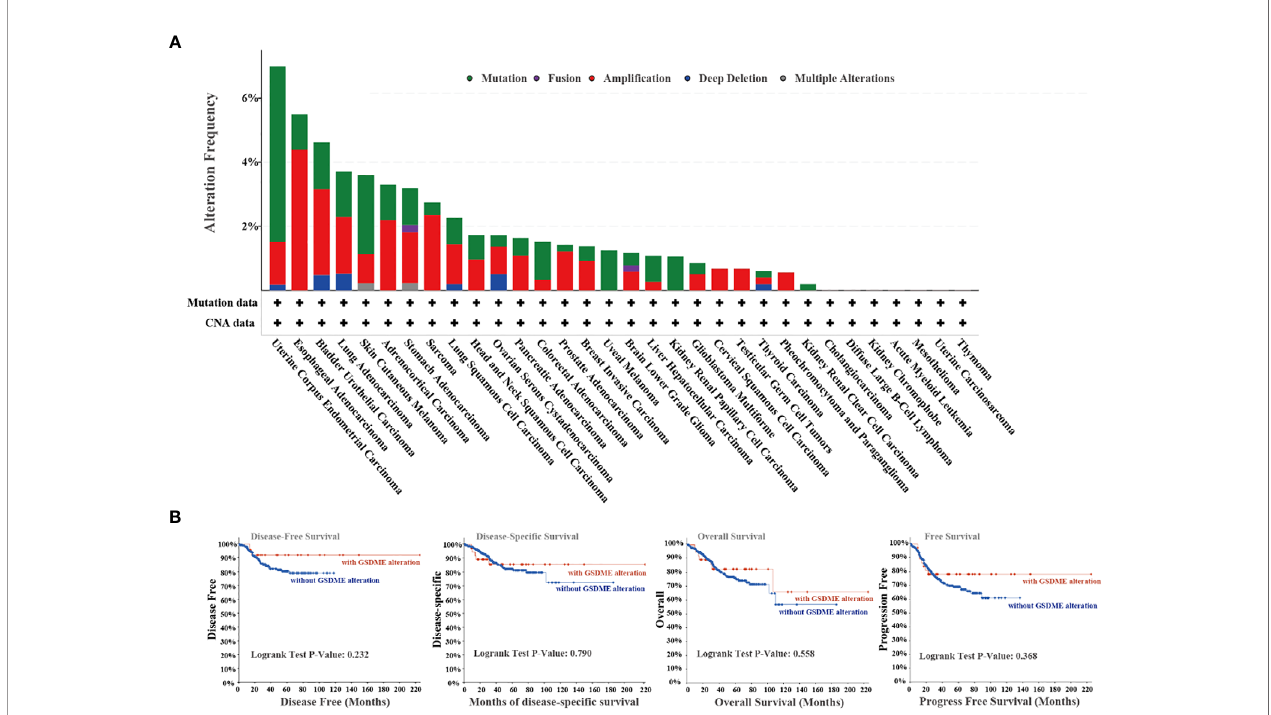
FIGURE 3 | (A) Alteration characterizes of GSDME in diverse cancers in TCGA project. (B) The potential relationship between mutation status and disease-free, disease-speci fi c, and progression-free survival from the cBioPortal